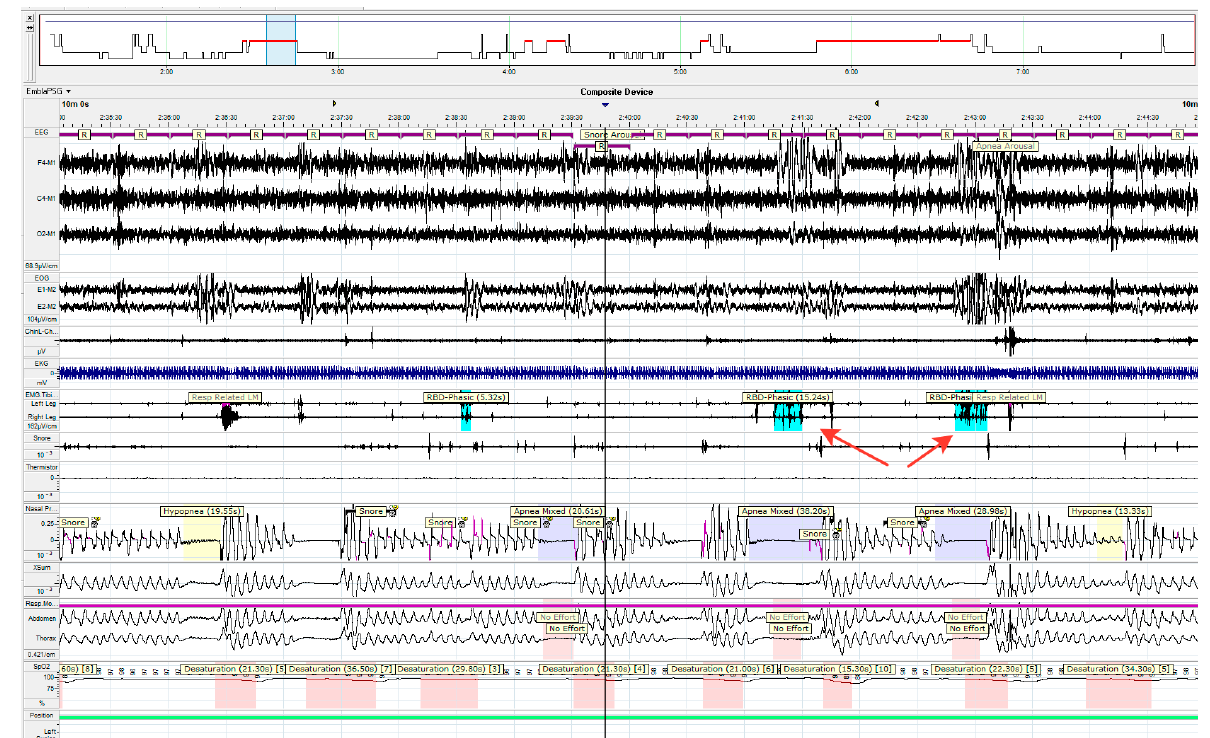
Figure 2. Abnormal motor activity during rapid eye movement sleep during two episodes of mixed apnea (arrows).